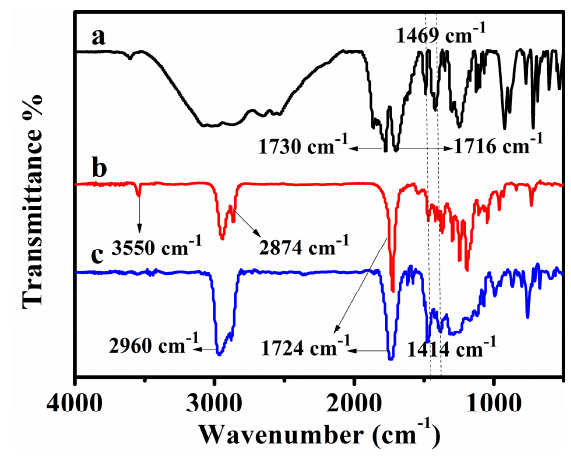
Figure 8. FT-IR spectra of ( a ) TMA, ( b ) polymer intermediates and ( c ) the product of base oil.